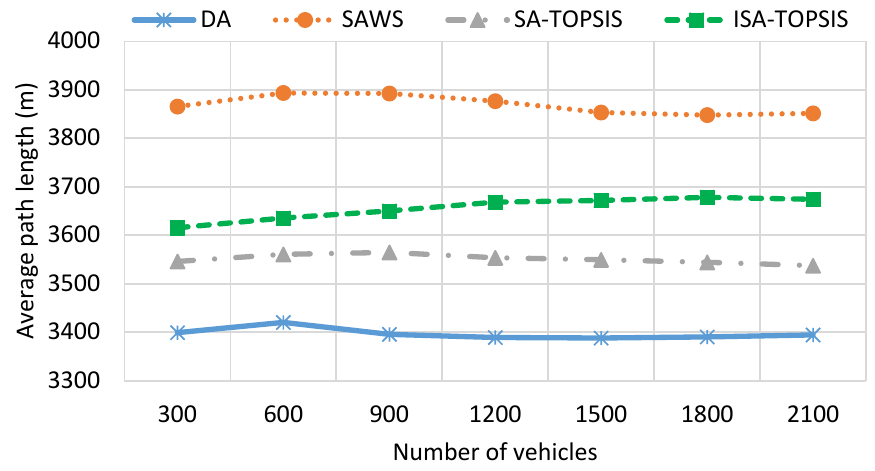
Figure 8. Average travel distance.